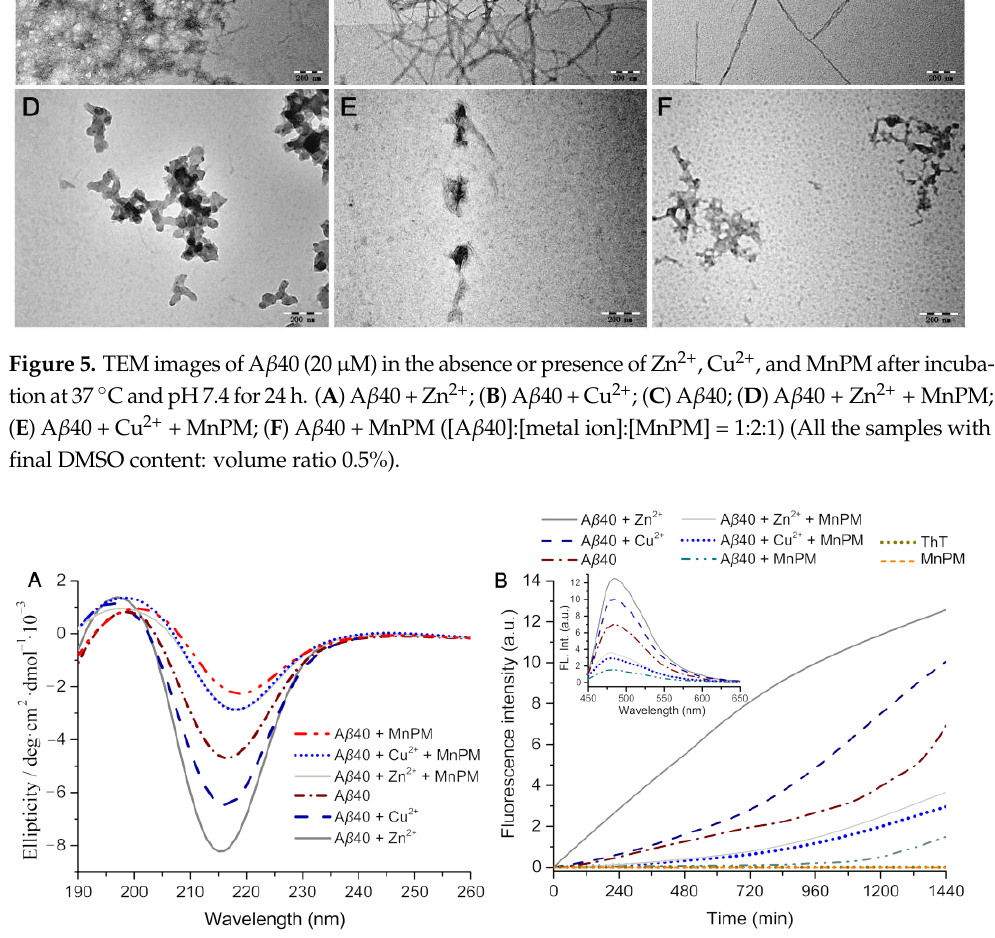
Figure 5. TEM images of A β 40 (20 μM) in the absence or presence of Zn 2+ , Cu 2+ , and MnPM after incubation at 37 °C and pH 7.4 for 24 h. ( A ) A β 40 + Zn 2+ ; ( B ) A β 40 + Cu 2+ ; ( C ) A β 40; ( D ) A β 40 + Zn 2+ + MnPM; ( E ) A β 40 + Cu 2+ + MnPM; ( F ) A β 40 + MnPM ([A β 40]:[metal ion]:[MnPM] = 1:2:1) (All the samples with final DMSO content: volume ratio 0.5%).